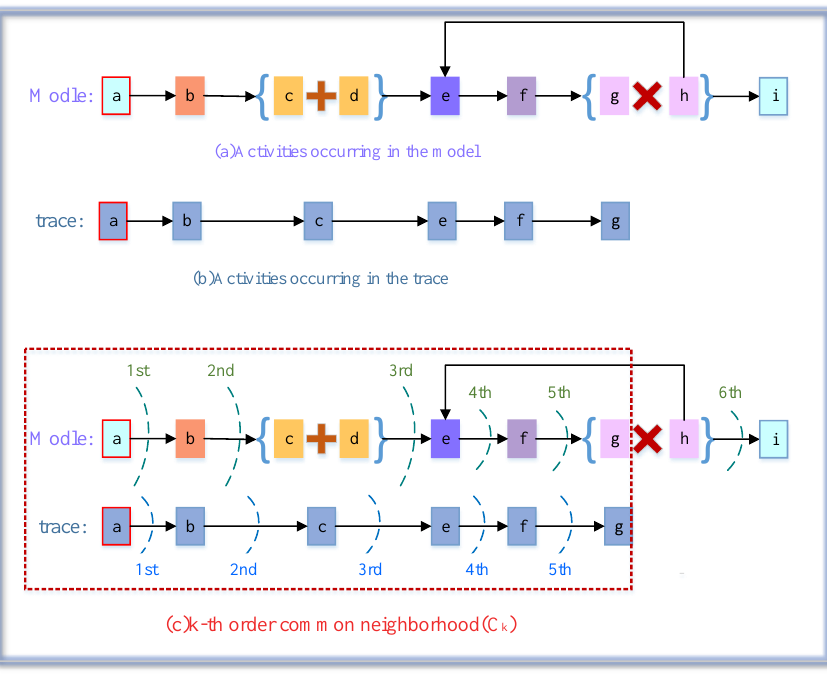
Figure 4. K-order neighborhood.